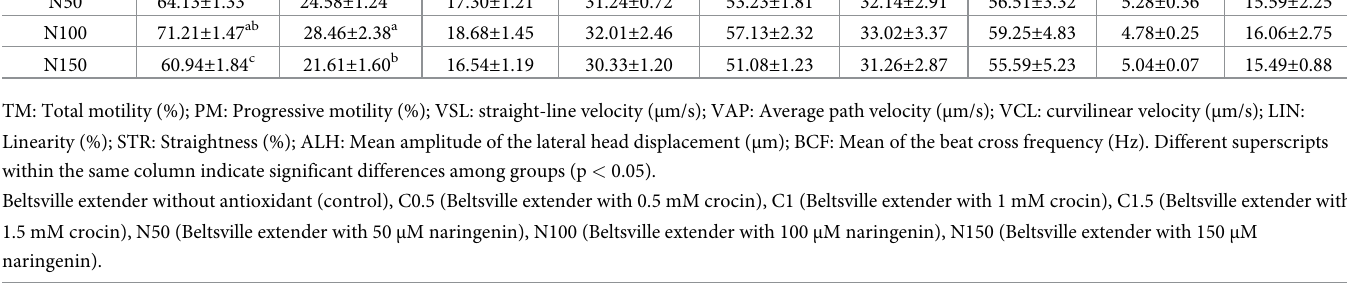
Table 3. Effect of different levels of crocin and naringenin on motility parameters of rooster thawed semen, analyzed by CASA ( n = 5). Antioxidant TM (%)